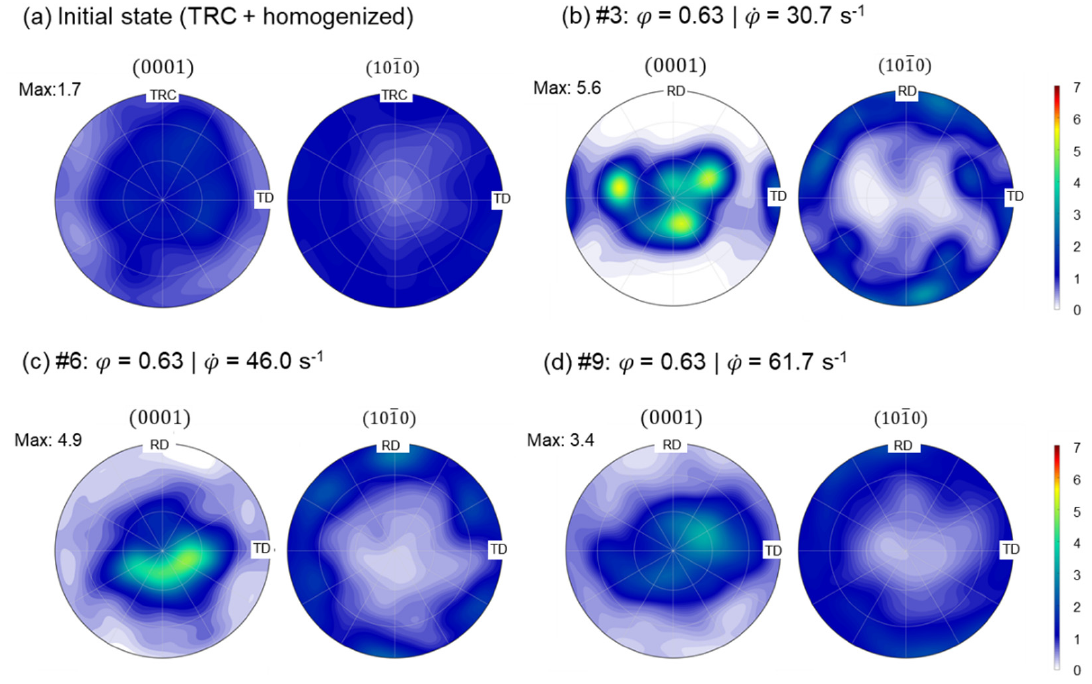
Figure 7. (0001) and (10 1(cid:3364) 0) pole figures of ( a ) the initial state, ( b ) sample #3, ( c ) sample #6, and ( d ) sample #9 .